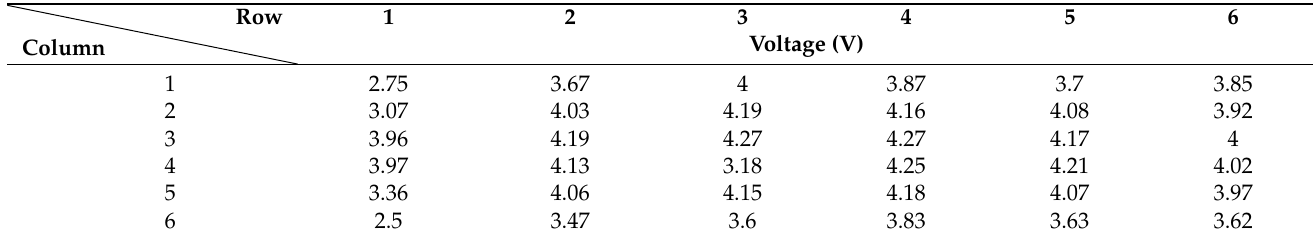
Table 3. The voltages of the photovoltaic cells irradiated by the 808 nm laser.